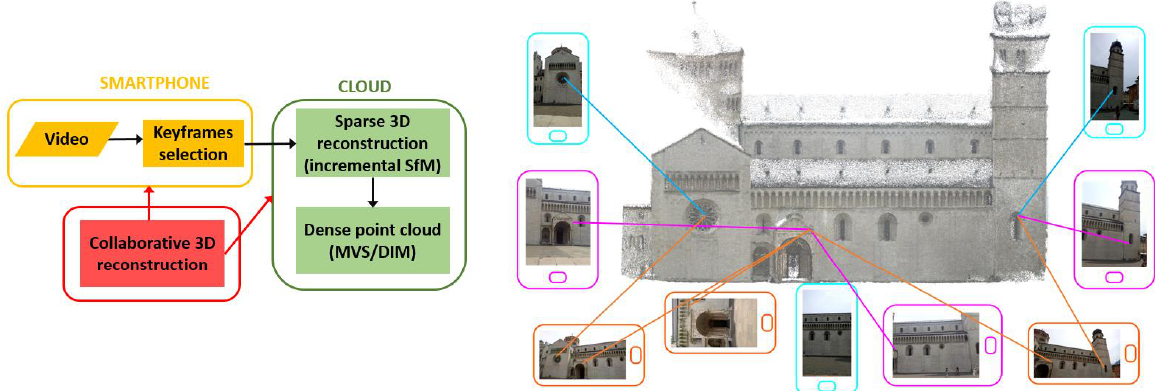
Figure 1: Part of the entire REPLICATE workflow (from Nocerino et al, 2017) jointly performed on smart devices and a cloud-based server (left) and the collaborative aspect of 3D digitization procedures presented in this article